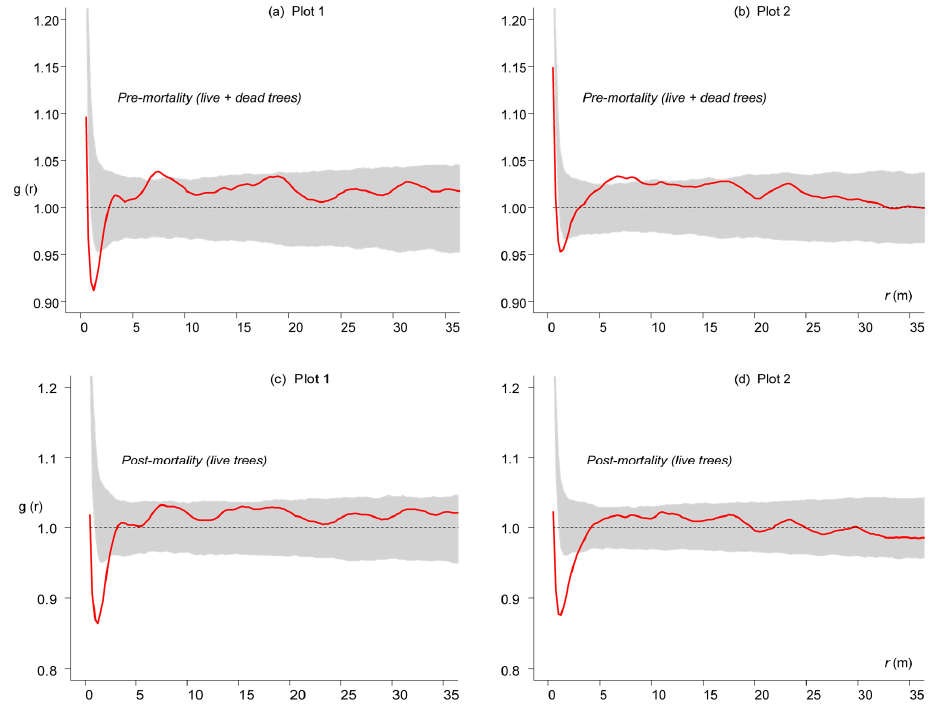
Figure 5. ( a , b ) Pair-correlation function of pre-mortality patterns (live and dead trees) and ( c , d ) post-mortality patterns (live trees) for plots 1 and 2, respectively. Red lines denote the observed pair-correlation function. The envelopes ( grey areas ) denote the range of pair-correlation function of a random spatial distribution pattern, and were constructed from the 2.5% and 97.5% quantiles of 1000 Monte Carlo simulations based on the complete spatial randomness null model. It implies a cluster or regular distribution pattern of points if the observed curve lies above or below the simulation envelopes, respectively.